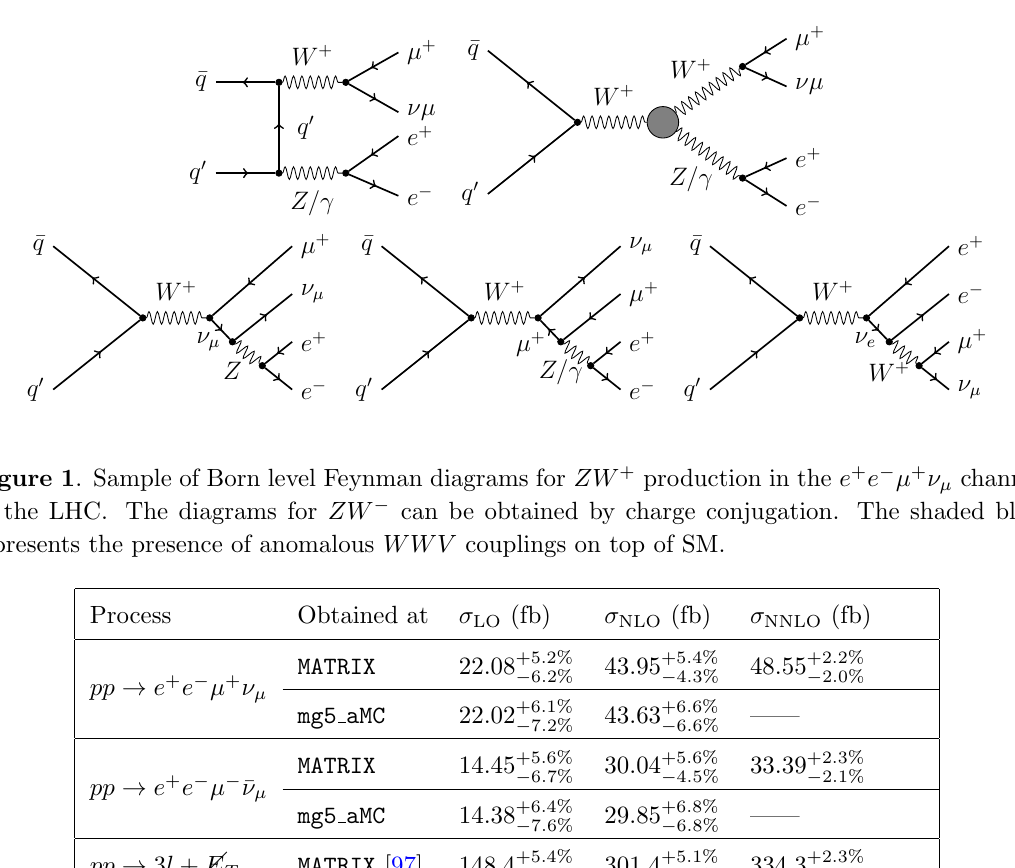
Table 2 . The theoretical estimates and experimental measurements of the cross sections of ZW production in the e + e (cid:0) (cid:22) (cid:6) (cid:23) (cid:22) = (cid:22) (cid:23) (cid:22) channels at p s = 13 TeV at the LHC for CMS (cid:12)ducial phase-space. The uncertainties in the theoretical estimates are due to scale